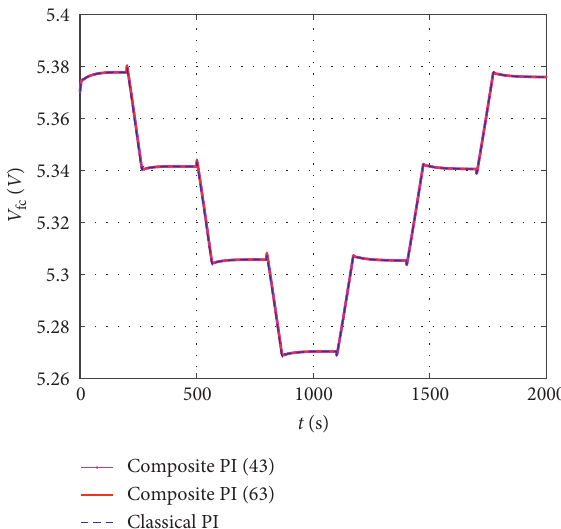
Figure 8: The voltage profiles regulated by the proposed composite PI controllers ((37) and (57)) and the classical PI.